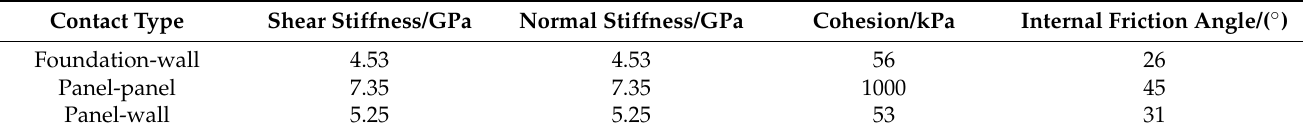
Table 5. Contact surface parameters.